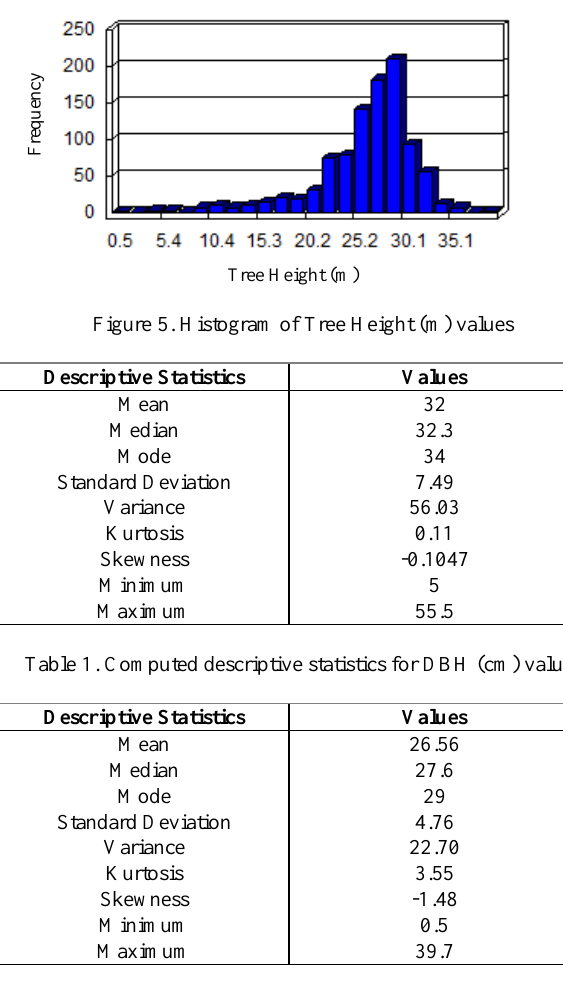
Table 2. Computed descriptive statistics for Tree Height